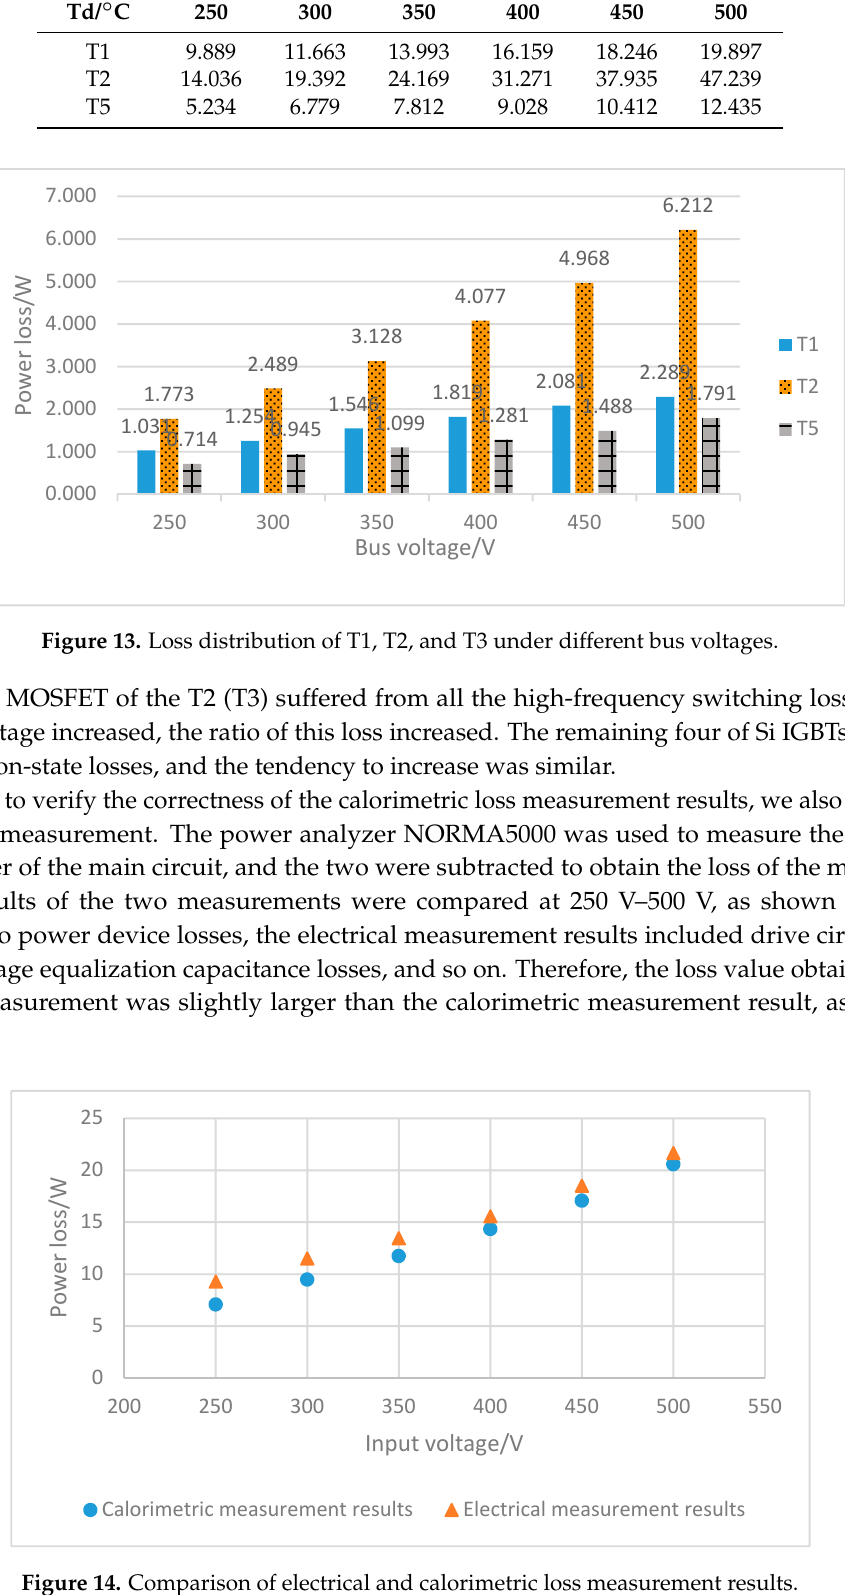
Figure 14. Comparison of electrical and calorimetric loss measurement results.